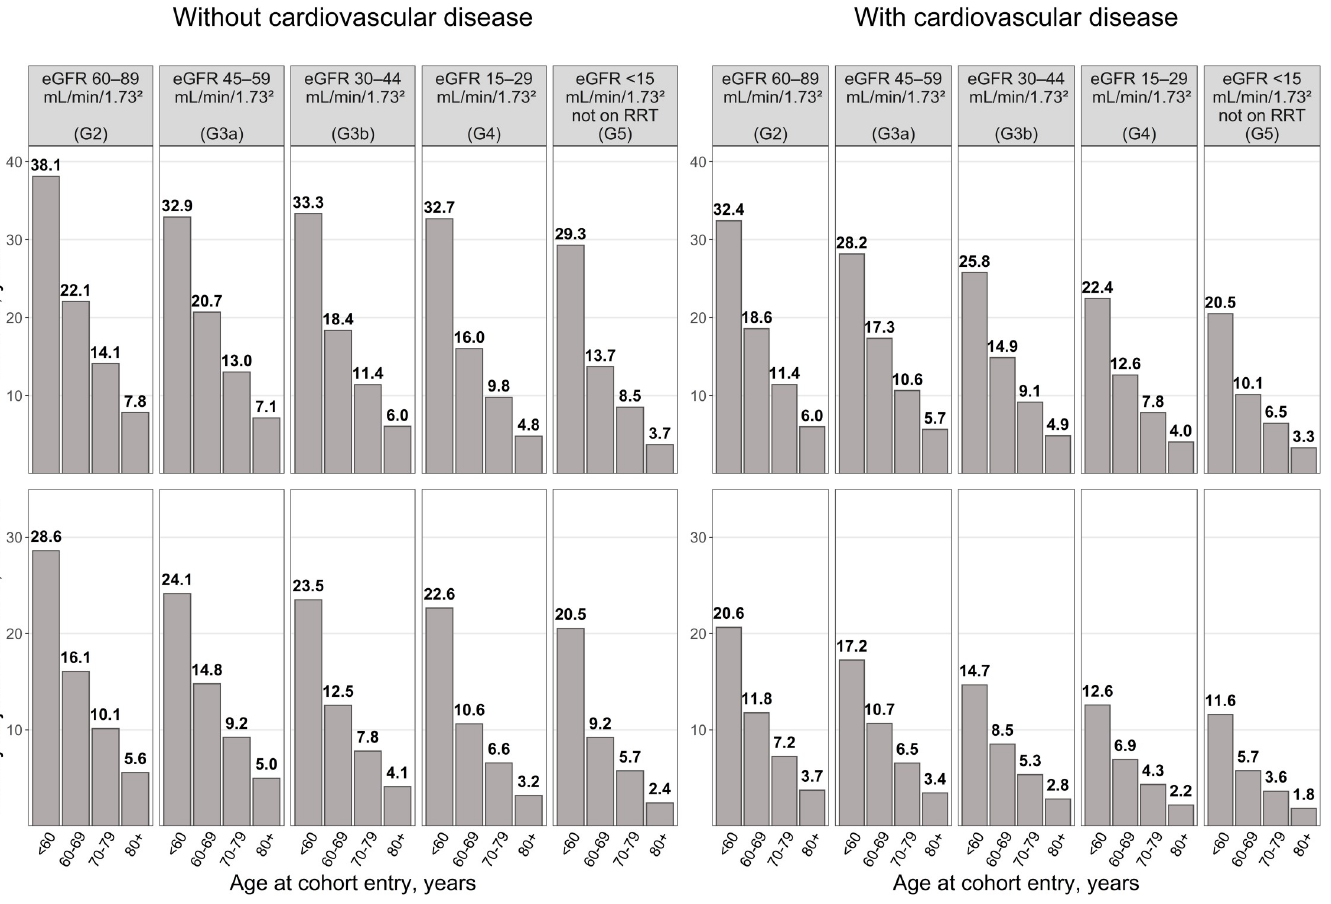
Fig 3. Predicted life expectancy and QALYs in the absence of cardiovascular prevention treatments by CVD history, age, and eGFR category at cohort entry. CKD–CVD, chronic kidney disease–cardiovascular disease; CVD, cardiovascular disease; eGFR, estimated glomerular filtration rate; QALY, quality-adjusted life year; RRT, renal replacement therapy. The predictions by the CKD–CVD model are based on a random sample of 64,000 patients from the whole cohort; see Methods section for further detail on how the sampling was performed.